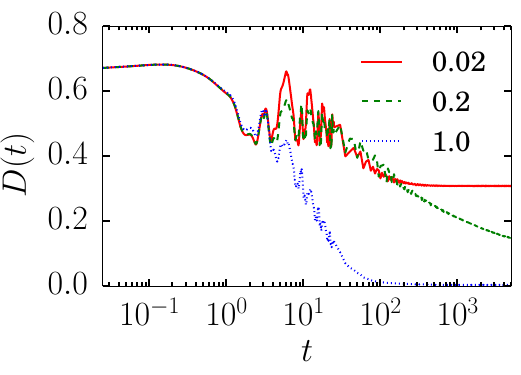
( 0 ) = | ψ 〉〈 ψ | and ρ ( 0 ) = | ψ 〉〈 ψ | Figure 7: Trace distance [ Eq. (19) ] between RDMs ρ N N 1 0 0 2 as a function of dimensionless time t . The antiferromagnetic Ising coupling strength is set to I = 0.25 J (weak coupling) and the intra-environment K is indicated in the legend (in units of S = 4 ( N = 16) particles. Time t has been made J ). The system (environment) consists of N (cid:69) S S / ħ h ≡ t . Non-monotonicity is a signature of dimensionless in units of J and ħ h , i.e. t (cid:48) → t (cid:48) J S S non-Markovian